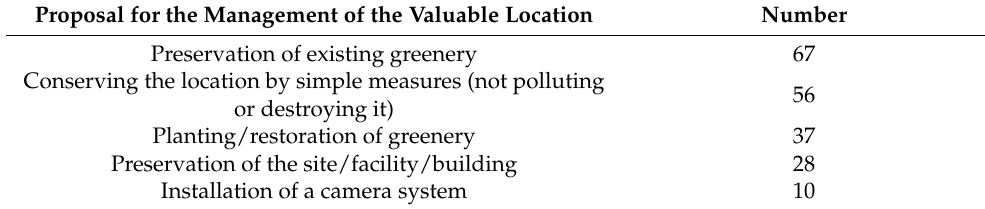
Table 4. Proposal for the management of valuable locations (in both built-up areas and open landscape)—all respondents.